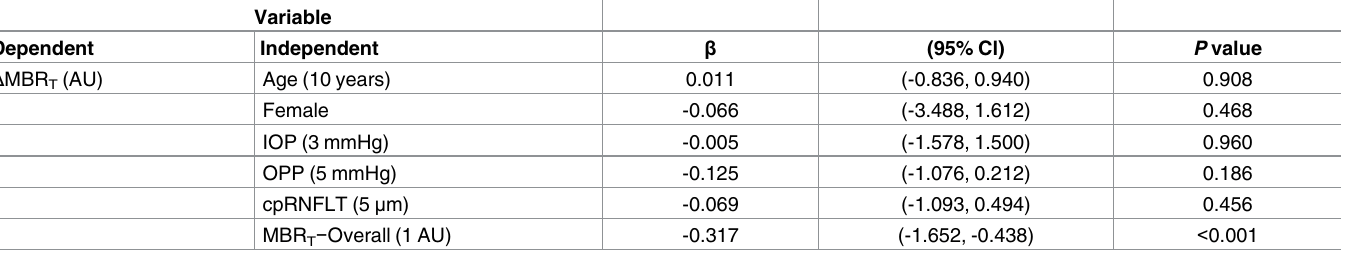
Table 4. Multiple linear regression analysis for change of ocular blood flow 2 hours after topical prostaglandin analogue administration in preperi- metric glaucoma